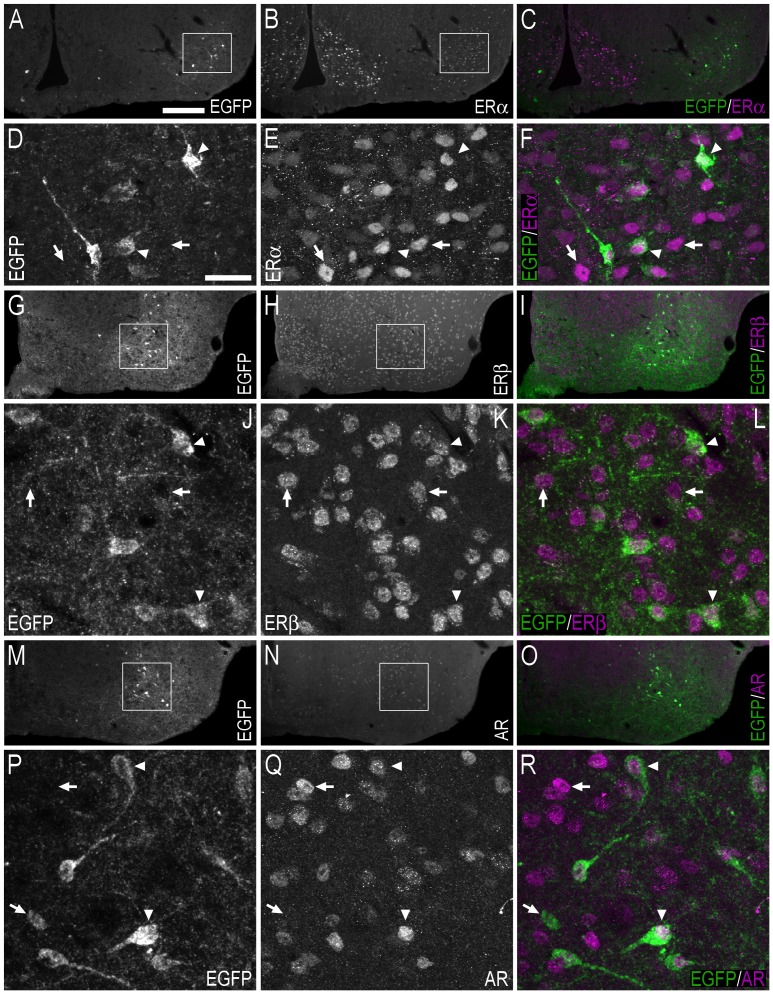
Double-immunofluorescence photo and confocal micrographs showing the distribution of EGFP−, ERα−, ERβ-, and AR-LI in the hypothalamus.(A–C) Single-channel photomicrographs of double-fluorescence immunohistochemistry (C), showing EGFP− (A) and ERα-LI (B) (Bregma, −1.94 mm). (D–F) Single-channel confocal micrographs of double-immunofluorescence (F), displaying EGFP− (D), and ERα-LI (E). The confocal micrographs in (D–F) are magnified views from the white squares shown in (A) and (B). (G–I) Single-channel photomicrographs of double-fluorescence immunohistochemistry (I), showing EGFP− (G) and ERβ-LI (H) (Bregma, −1.94 mm). (J–L) Single-channel confocal micrographs of double-immunofluorescence (L), displaying EGFP− (J), and ERβ-LI (K). Confocal micrographs in (J–L) are magnified views of the white squares shown in (G) and (H). (M–O) Single-channel photomicrographs of double-fluorescence immunohistochemistry (O), showing EGFP− (M) and AR-LI (N) (Bregma, −1.46 mm). (P–R) Single-channel confocal micrographs of double-immunofluorescence (R), displaying EGFP− (P), and AR-LI (Q). Confocal micrographs in (P–R) are magnified views of the white squares shown in (M) and (N). In D–F, J–L, P–R, arrows point to single labelled cell bodies, and arrowheads point to double-labelled cell bodies. Scale bars: A = 200 µm, applies A–C, G–I, M–O; D = 25 µm, applies D–F, J–L, P–R.